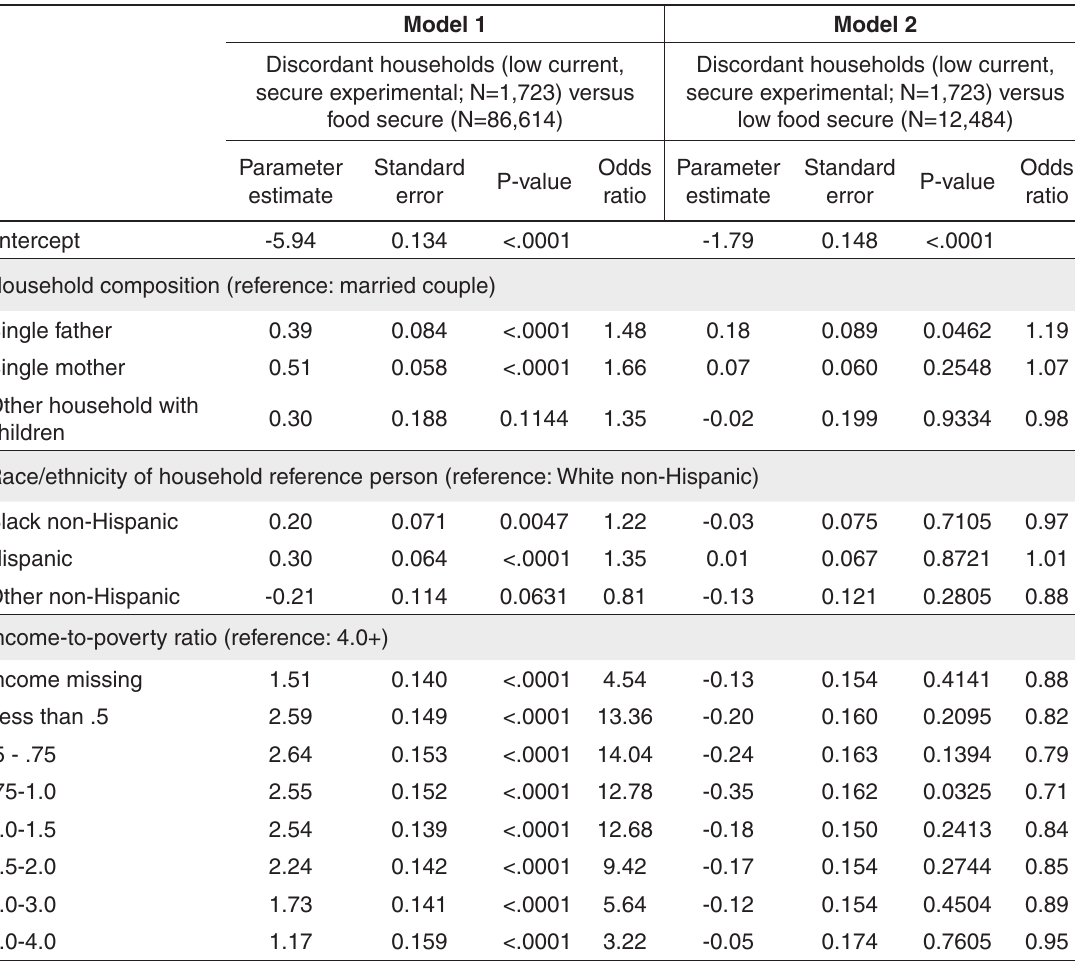
Logistic regression model comparing discordant households (low food secure current, food secure experimental) with households consistent on both classification methods, 2008-15 Model 1 Model 2 Discordant households (low current, secure experimental; N=1,723) versus secure experimental; N=1,723) versus food secure (N=86,614) Standard estimate